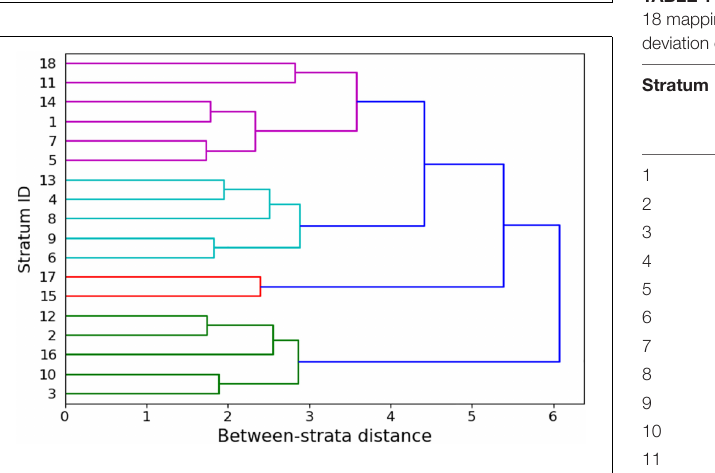
FIGURE 4 | Dendrogram of the between-strata Euclidean distance within the reduced input set yielding 18 strata in the last iteration of Step 1 ( Figure 2 ).